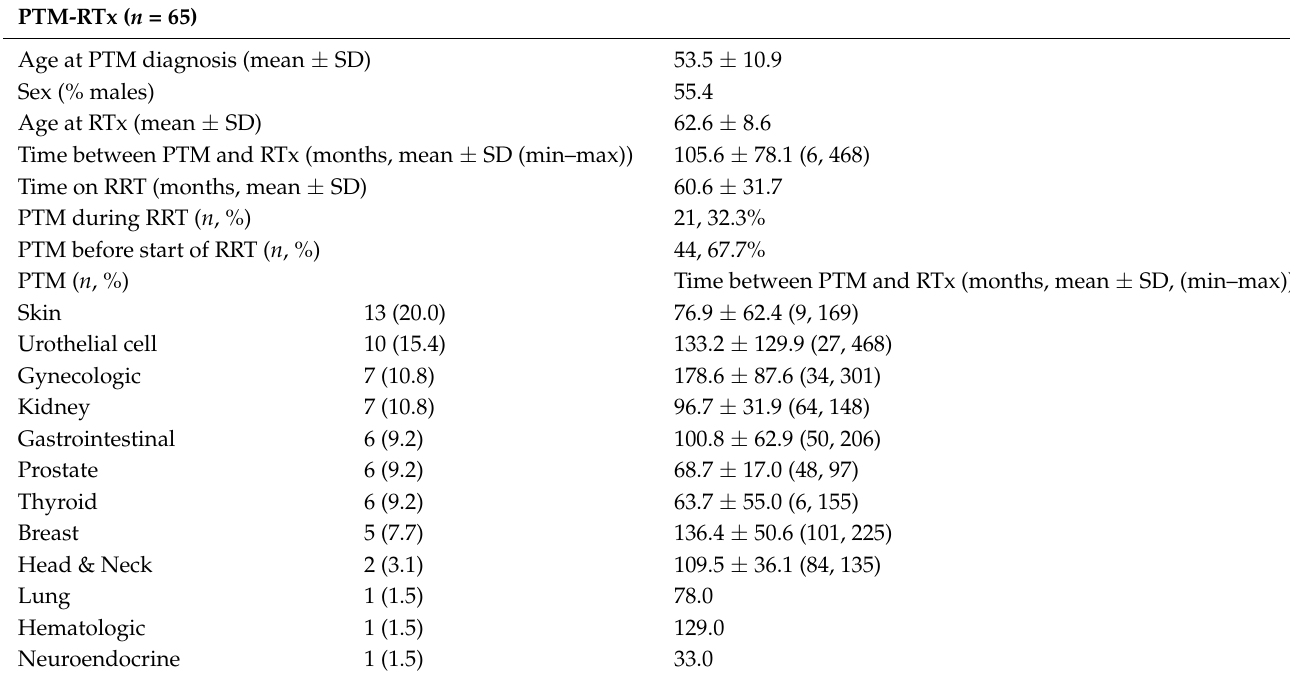
Table 1. Baseline characteristics of recipients with a history of pretransplant